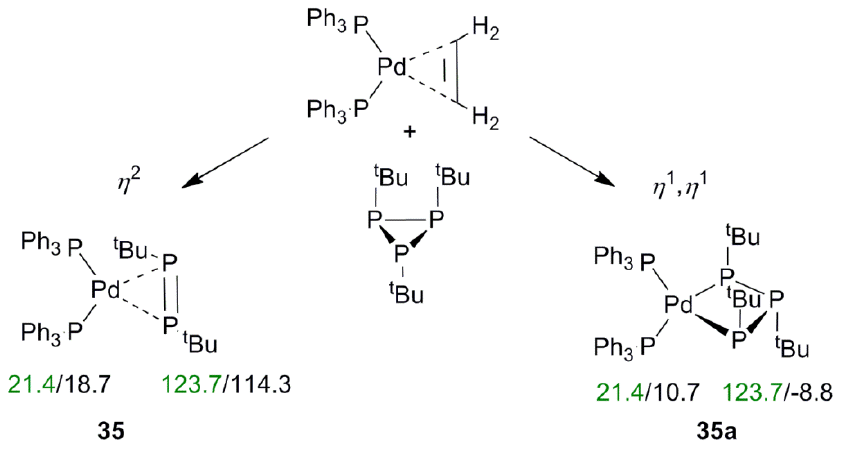
Figure 6. Structures of complexes 35 and 35a with experimental (green) and calculated (black) 31 P CSs (in ppm) included.